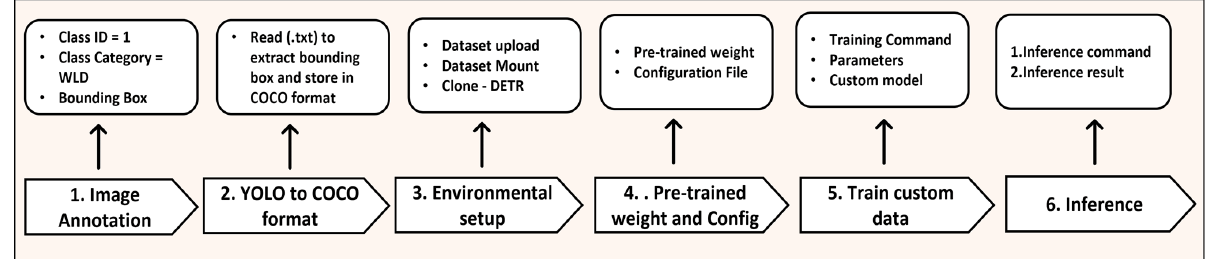
Figure 7. Main steps in the development of DETR model.